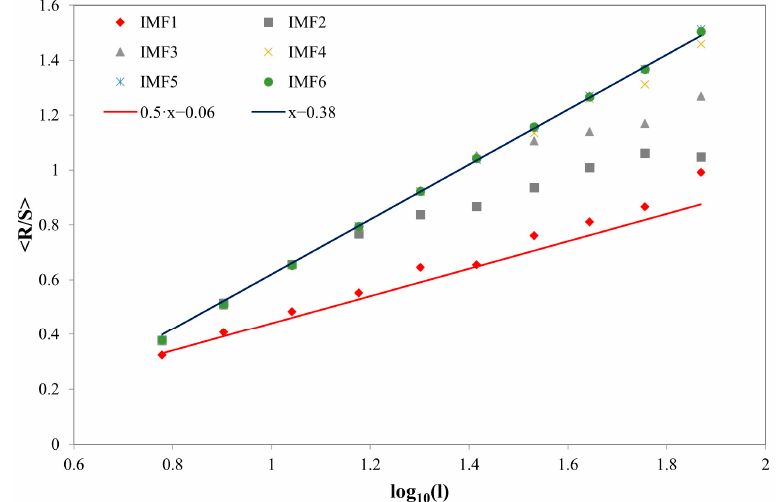
Figure 15. Hurst analysis for the deseasonalized and detrended reconstructed mean July air temperatures timeseries.